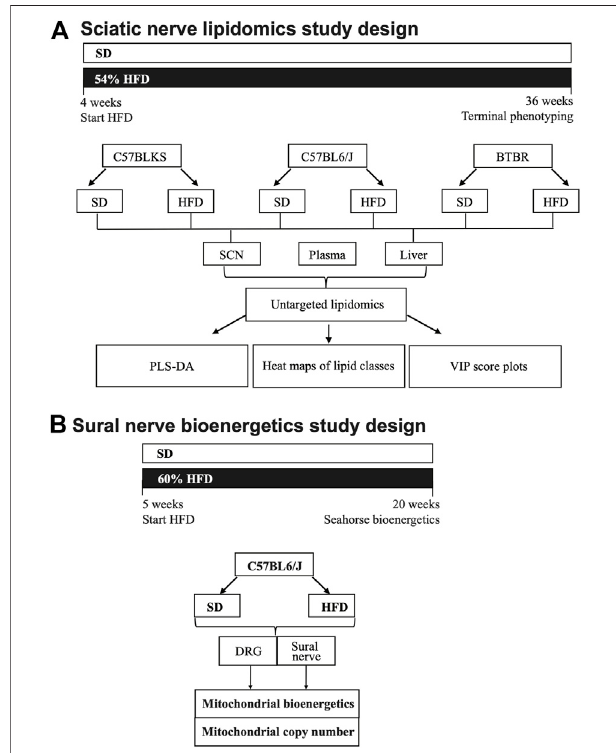
FIGURE 1 | Study paradigm and work fl ow for lipidomics (A) and mitochondrial bioenergetics analysis (B) . (A) Three strains ofmice (C57BLKS/ J, C57BL6/J, and BTBR) were divided into two groups per strain and fed either a standard diet (SD) or 54% high-fat diet (HFD). Mice were fed SD or HFD for 32 weeks and phenotyped for metabolic and neuropathy parameters at 36 weeks. At 36 weeks, sciatic nerve, liver, and plasma were collected and processed for LC-MS/MS lipidomics analysis. Lipidomics data were subjected a bioinformatics pipeline including PLS-DA, heat maps, and VIP score plots. (B) DRG neuron and sural nerve mitochondrial bioenergetics were evaluated in BL6 mice fed a SD or 60% HFD from 5 to 20 weeks. At 20 weeks of age, mitochondrial bioenergetics and mitochondrial copy number were assessed in DRG neurons and whole sural nerves from HFD BL6 mice compared to SD BL6